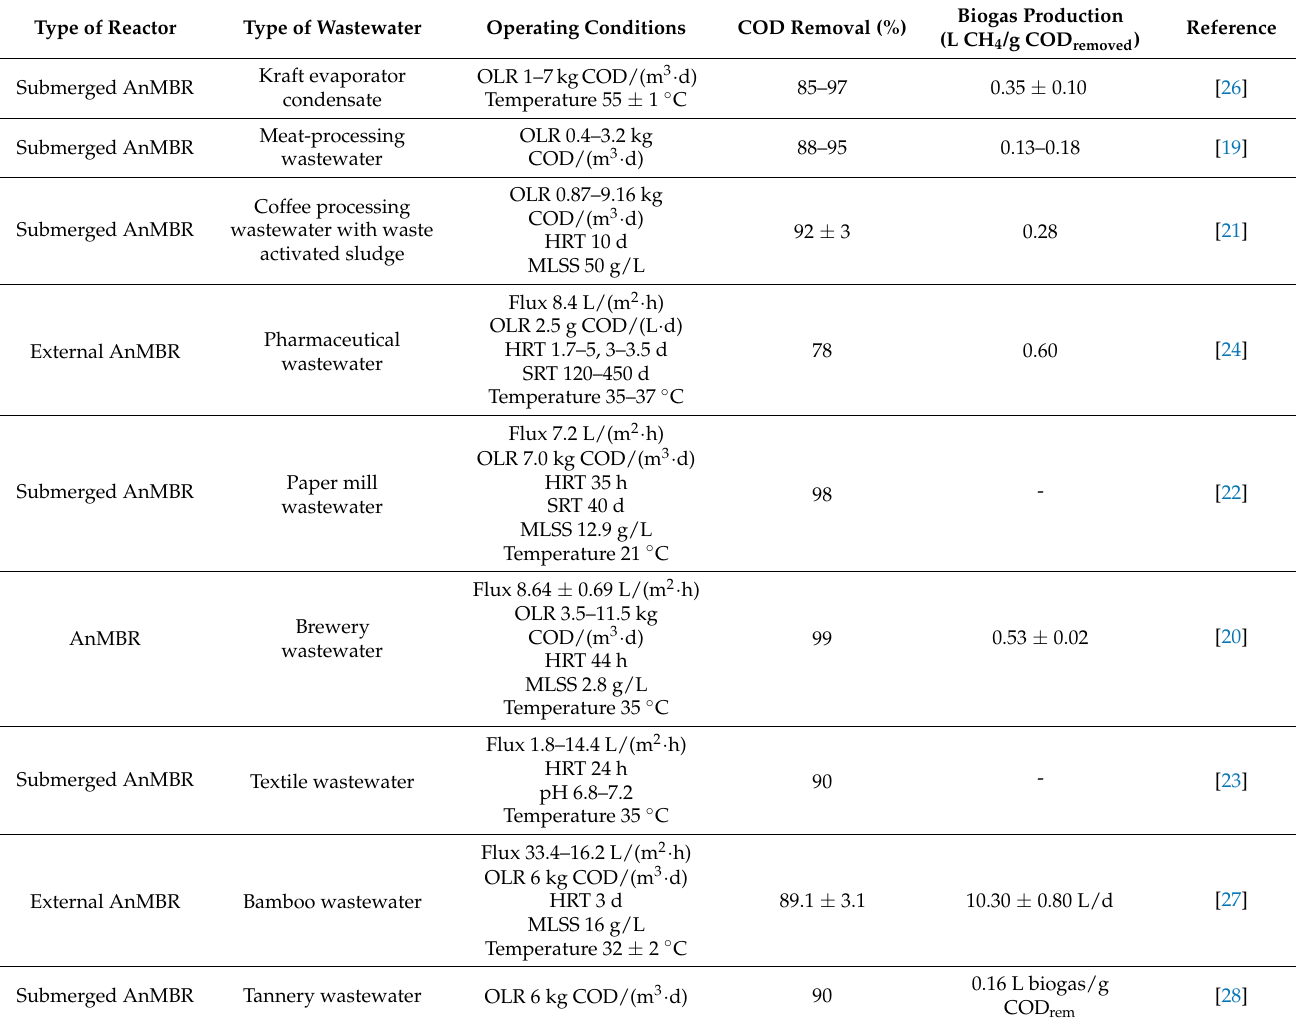
Table 1. Examples of AnMBR applications for the treatment of industrial